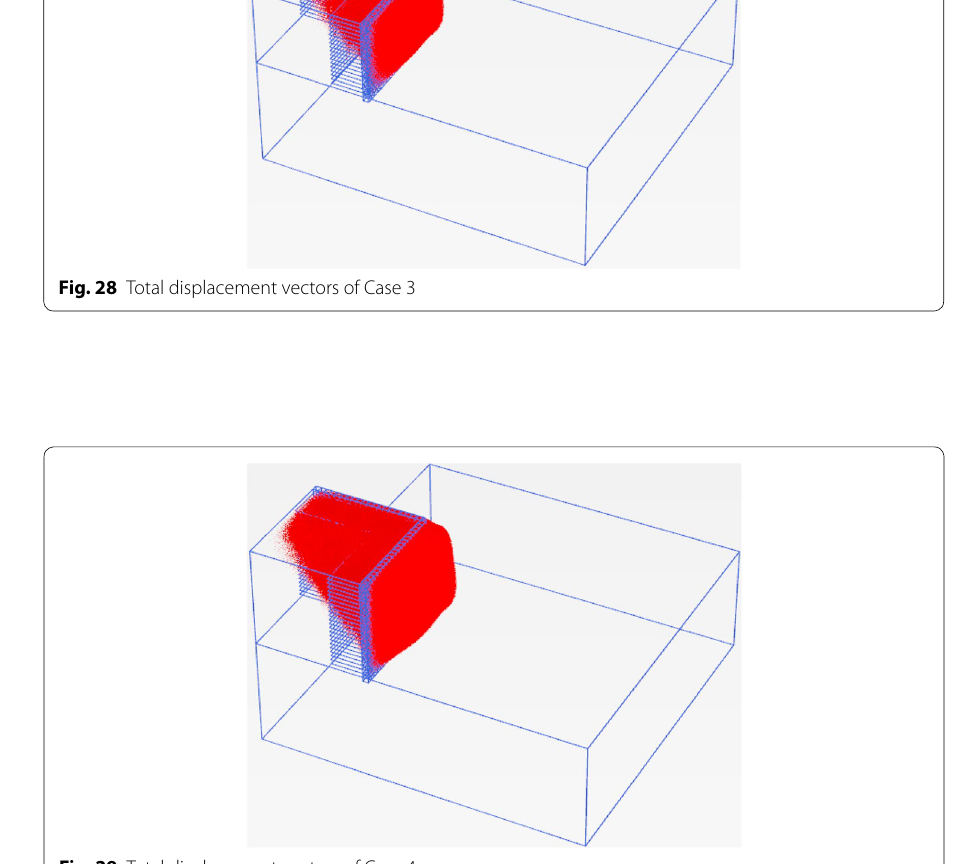
Fig. 29 Total displacement vectors of Case